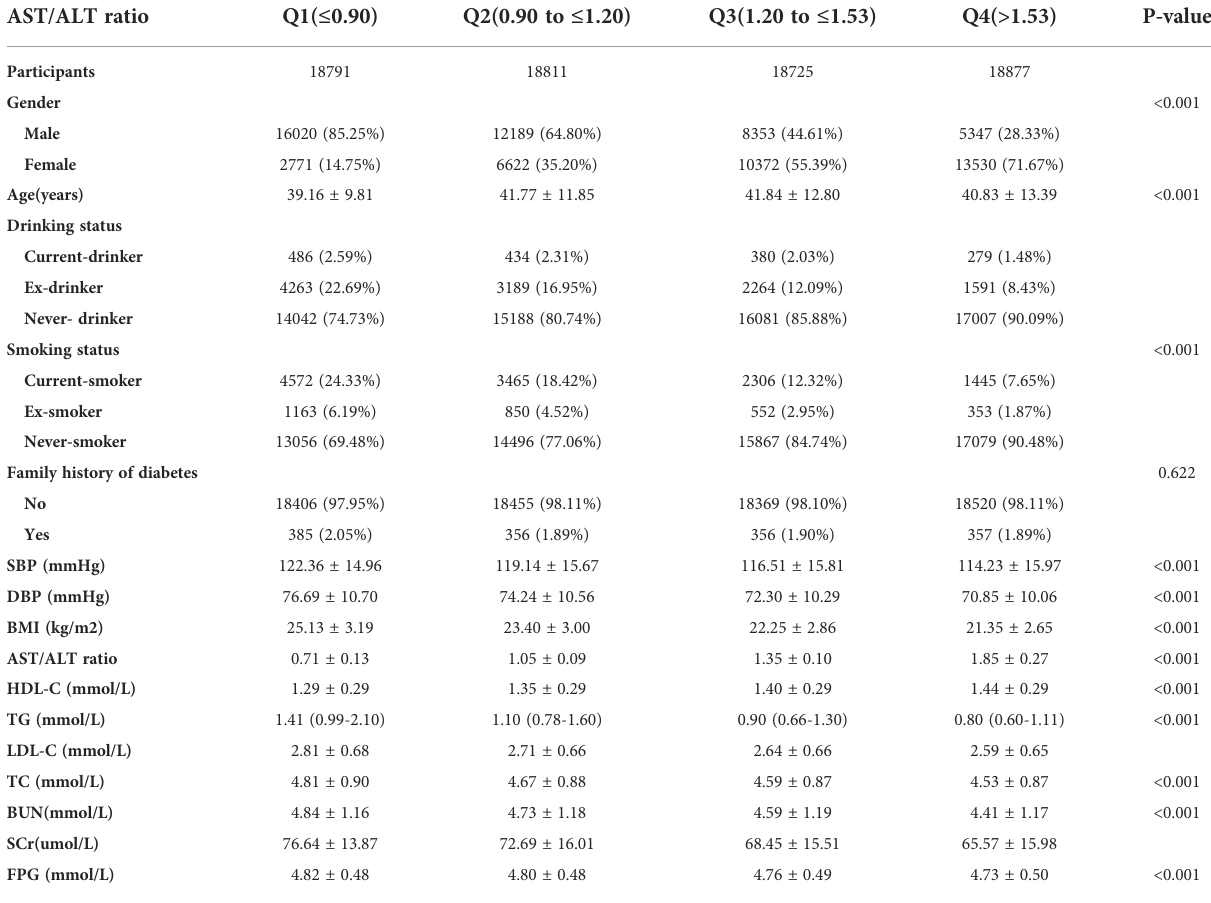
TABLE 1 The baseline characteristics of participants